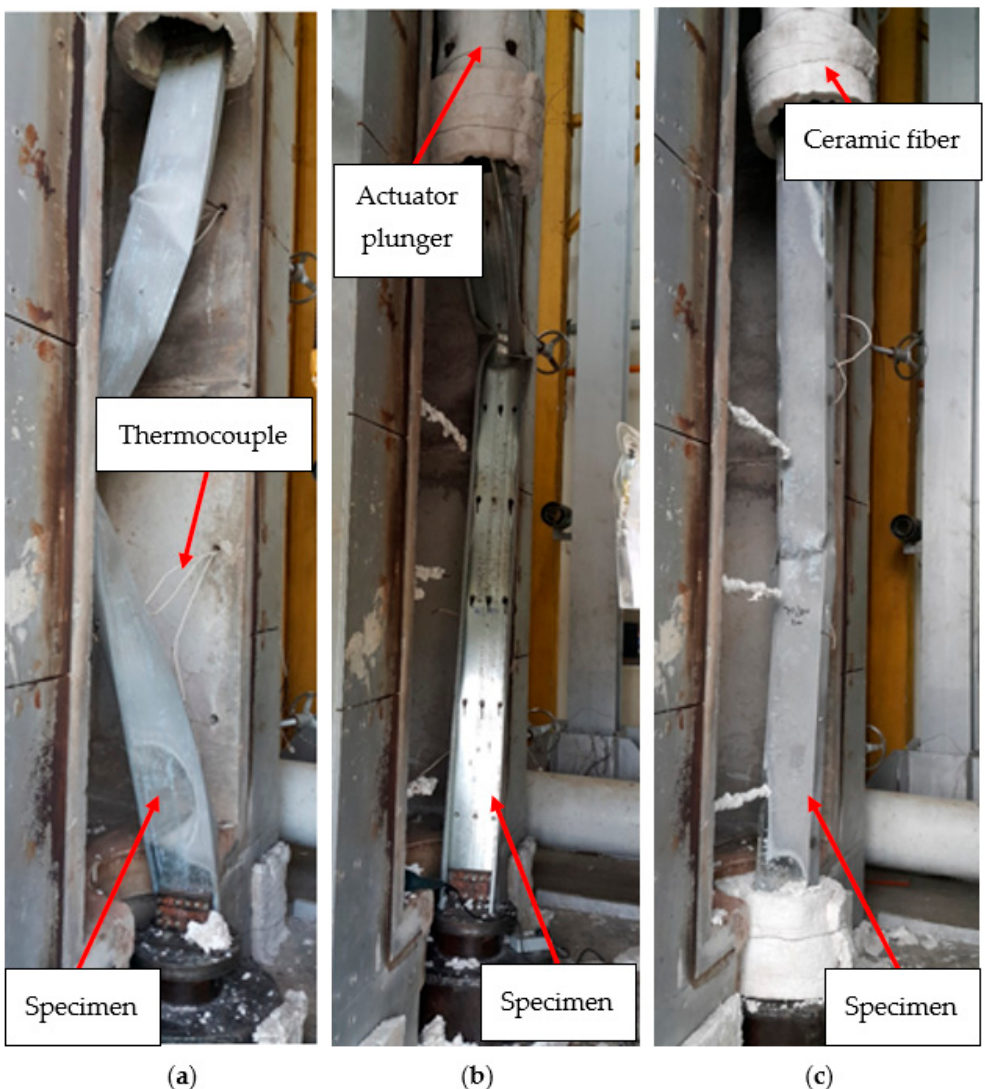
Figure 18. Experimental testing CFS column under fire. ( a ) Channel; ( b ) BTB; ( c ) BU.